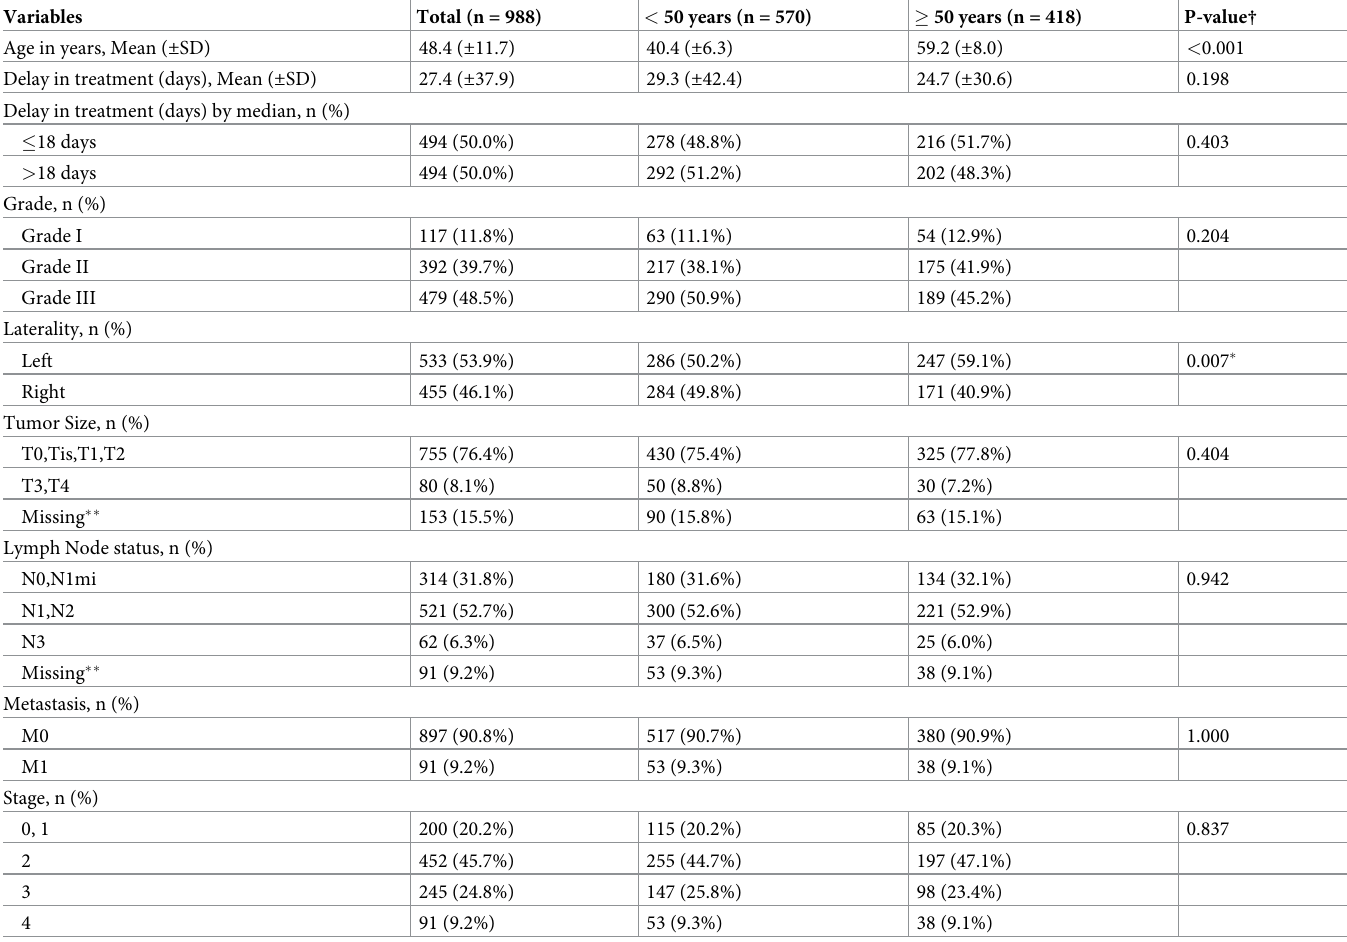
Table 1. Demographic, clinical and pathological characteristics at baseline, overall and by age